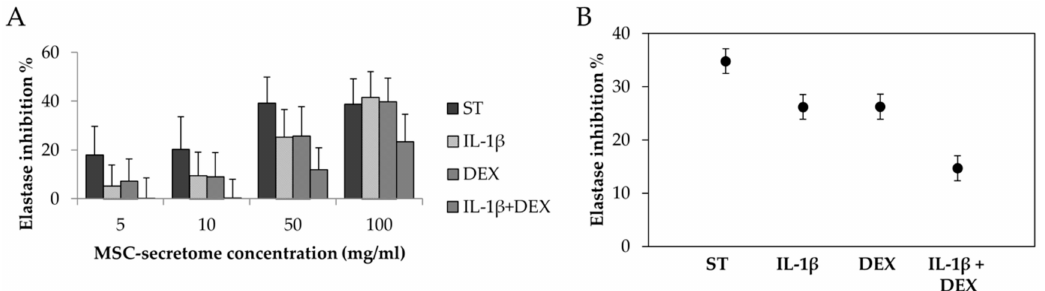
Figure6. ( A )Anti-elastaseactivitiesoffreeze-driedMSC-secretomeobtainedstimulatingAD-MSCswith IL-1 β and / or DEX; mean values ± standard deviation, n = 3. ( B ) Results of average elastase inhibition